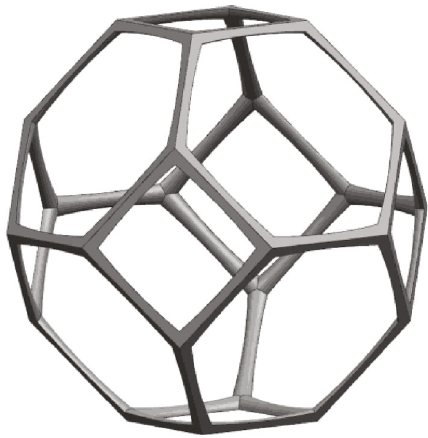
Figure 2: Ideal tetrahedral model of foam metal.